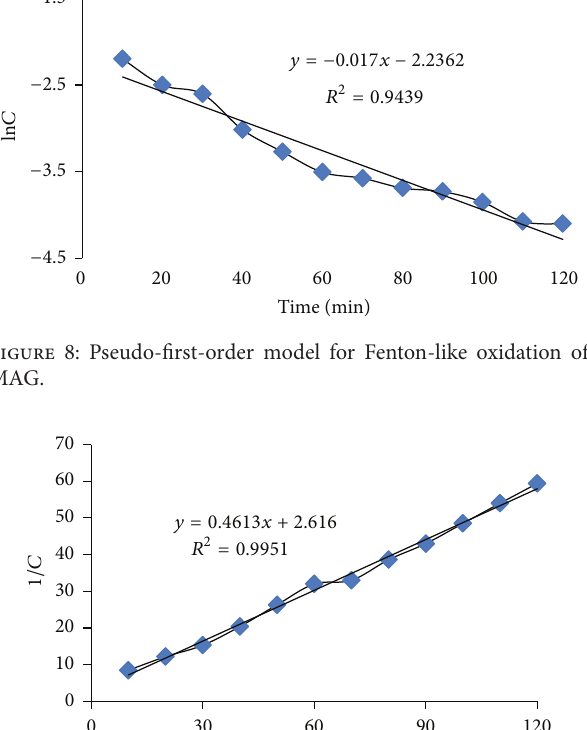
Figure 9: Pseudo-second-order model for Fenton-like oxidation of